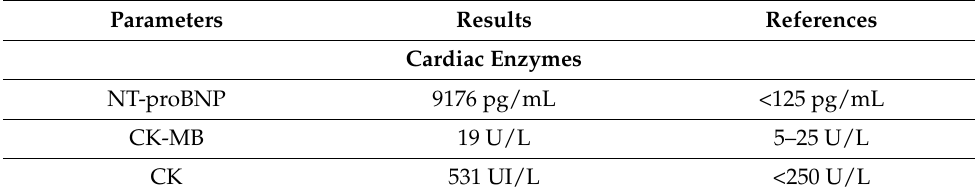
Table 2. Cardiac laboratory parameters on admission.